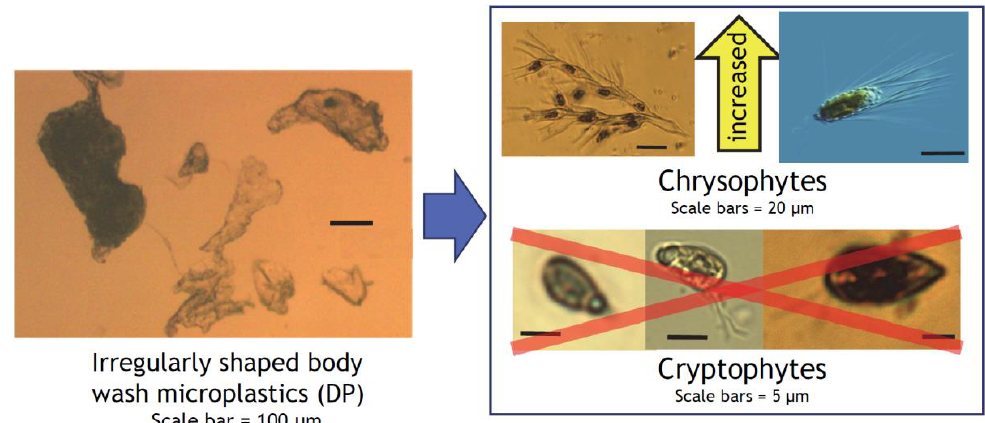
Figure 7. Conceptual diagram of the differential effects of irregularly shaped body wash MPs on Chrysophytes and Cryptophytes, with images of representative taxa identified in this study. Images are not to scale. Inside the right box: Mallomonas sp. image ( upper right ) is licensed under CC BY-NC-SA 2.0 [53]; images of Dinobryon divergens ( upper left ), Chroomonas - ( lower left and middle ) and Rhodomonas -like ( lower right ) cryptophytes are from this and past studies from Otsego Lake phytoplankton.